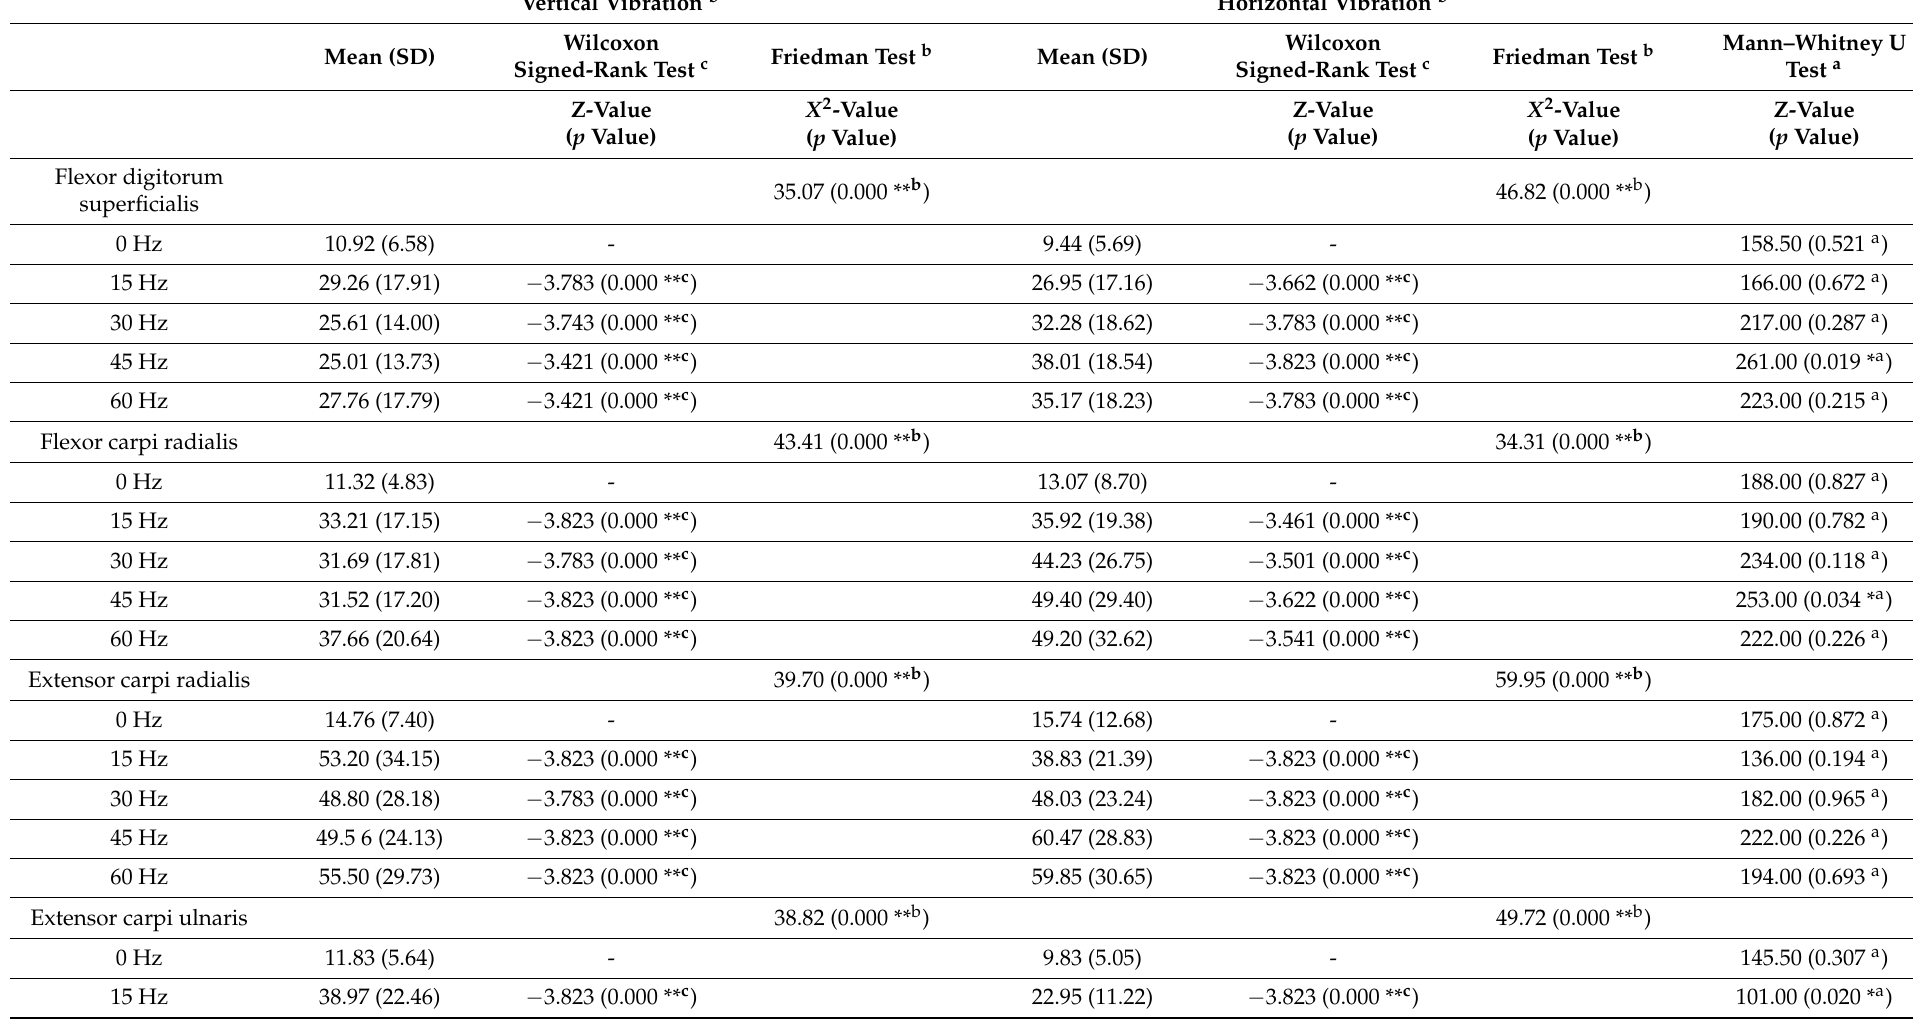
Table 2. Vibration-induced changes in EMGrms (%) compared with those in the no-vibration